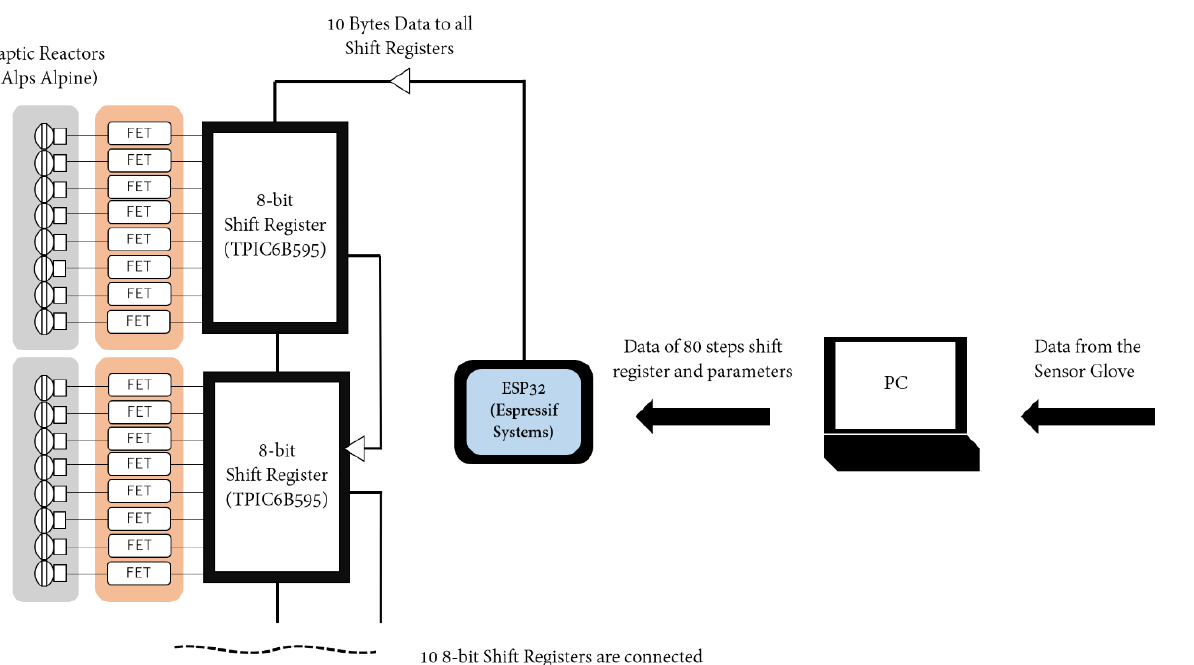
Figure 3. Hardware configuration of the haptics vest.